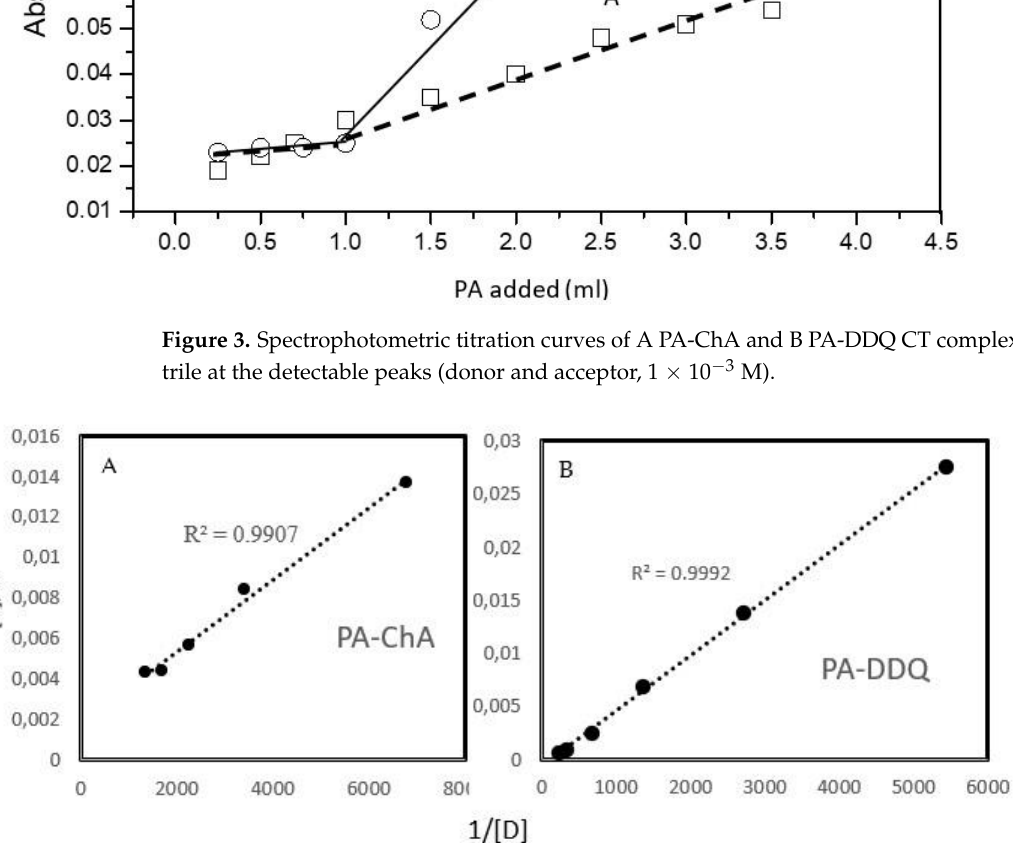
Figure 4. The 1:1 Benesi – Hildebrand plot of procainamide CT complexes at detectable peaks: ( A ) for PA-ChA and ( B ) PA-DDQ.